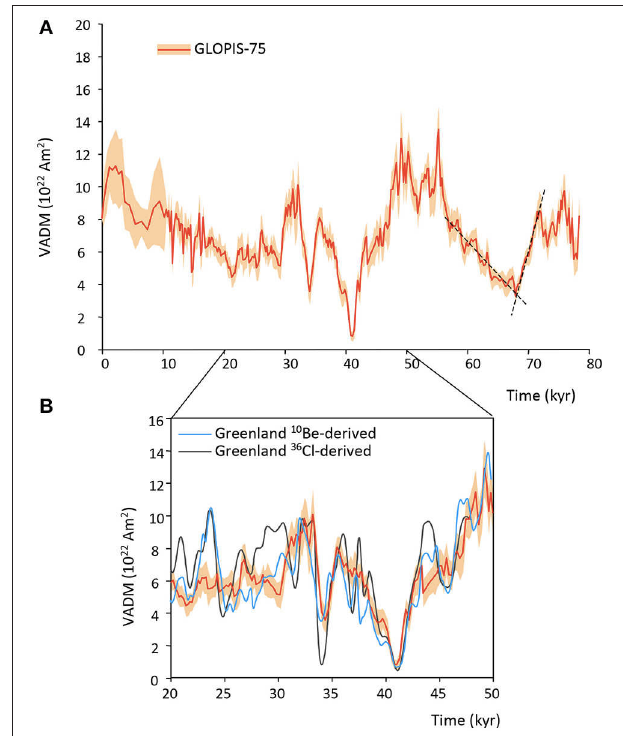
FIGURE 2 | (A) GLOPIS-75 record for the 0–80 kyr time interval reported vs. the Greenland ice GICC05 age model. A slight time adjustment has been made around the Mono Lake excursion, following Laj et al. (2014). The dashed lines are for the decay and growth rates before and after the geomagnetic dipole low around 68 ka. (B) Comparison for the 20–50 kyr time interval of GLOPIS-75 record (in red) with the two curves derived from 10 Be